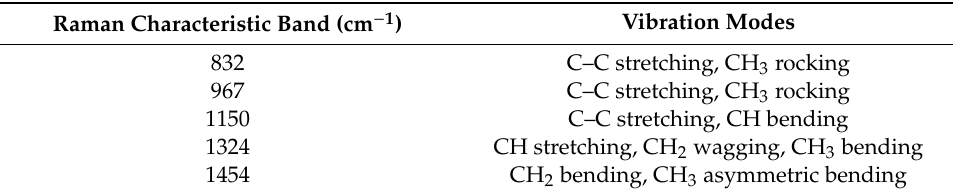
Table 1. Vibrational modes for Raman Bands of PP [28].